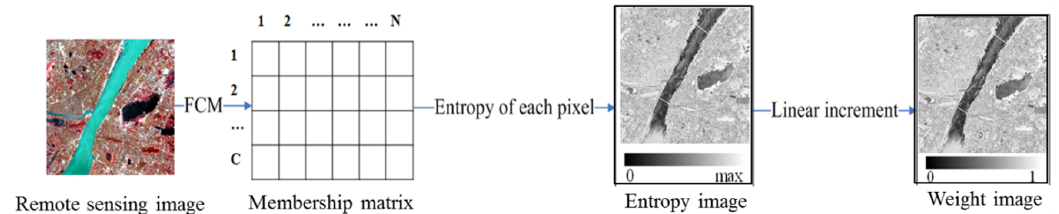
Figure 2. The flowchart of adaptive weight parameter determination in KADESFC.